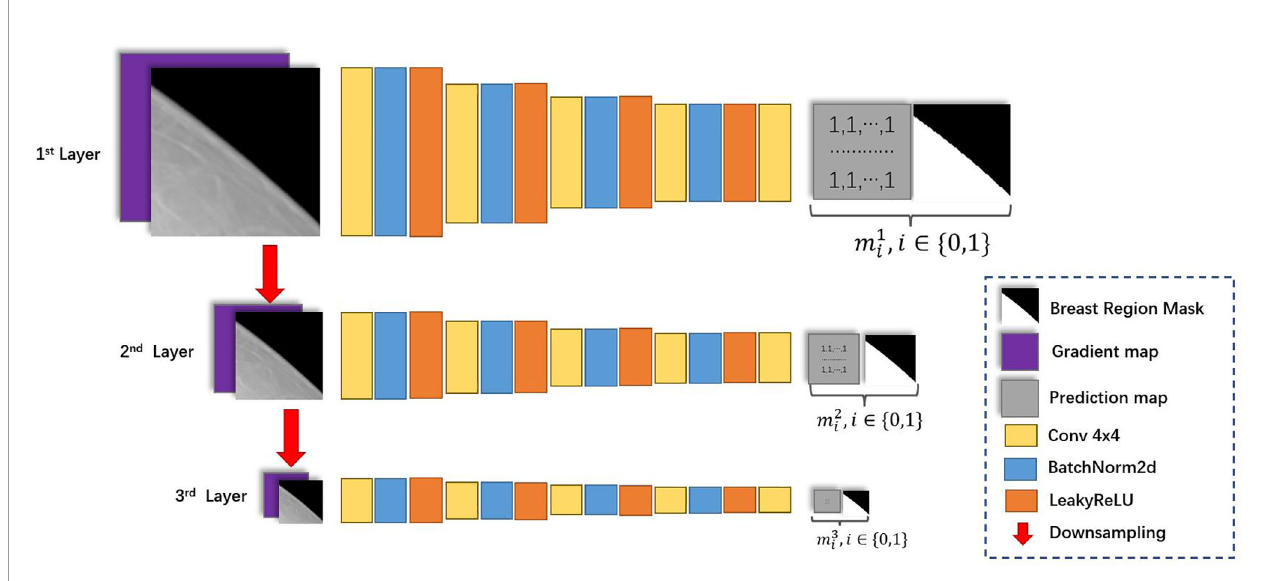
FIGURE 3 | The network architecture of the